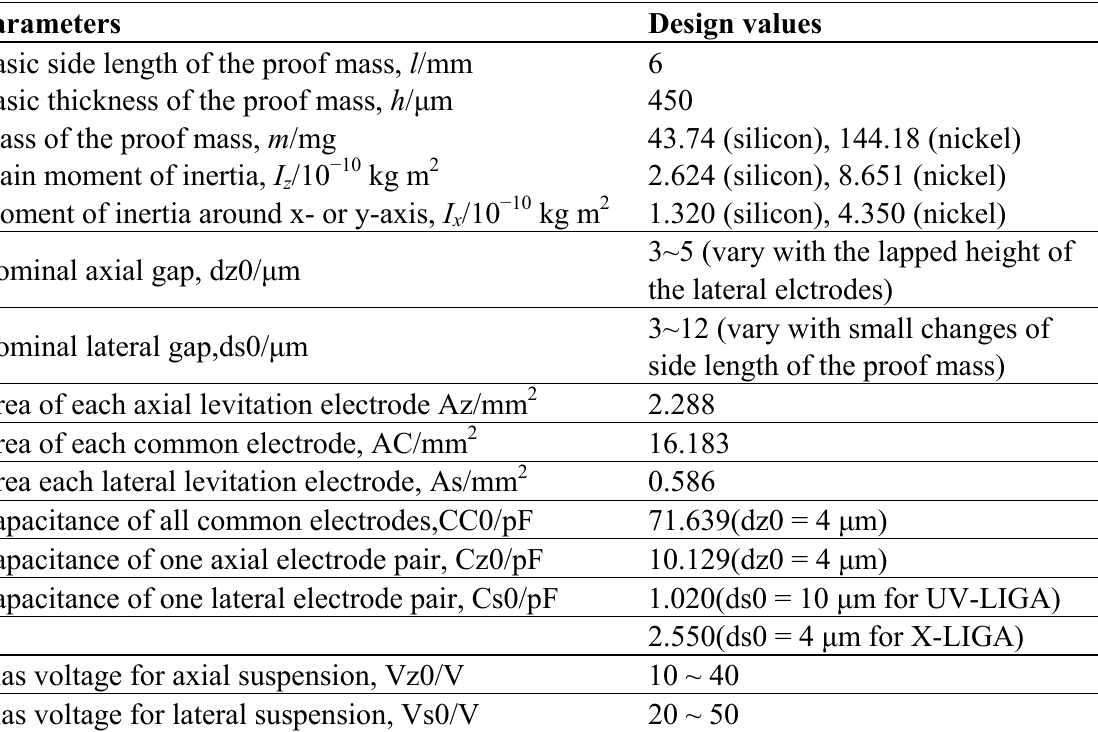
Table 1. Main design parameters of the first prototype of